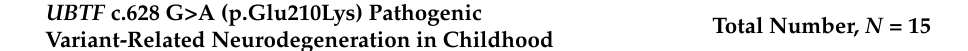
Table 1. Demographic data, clinical manifestations, neuroimaging findings, and clinical outcomes of 15 individuals with UBTF c.628 G>A (p.Glu210Lys) pathogenic variant-related neurodegeneration in